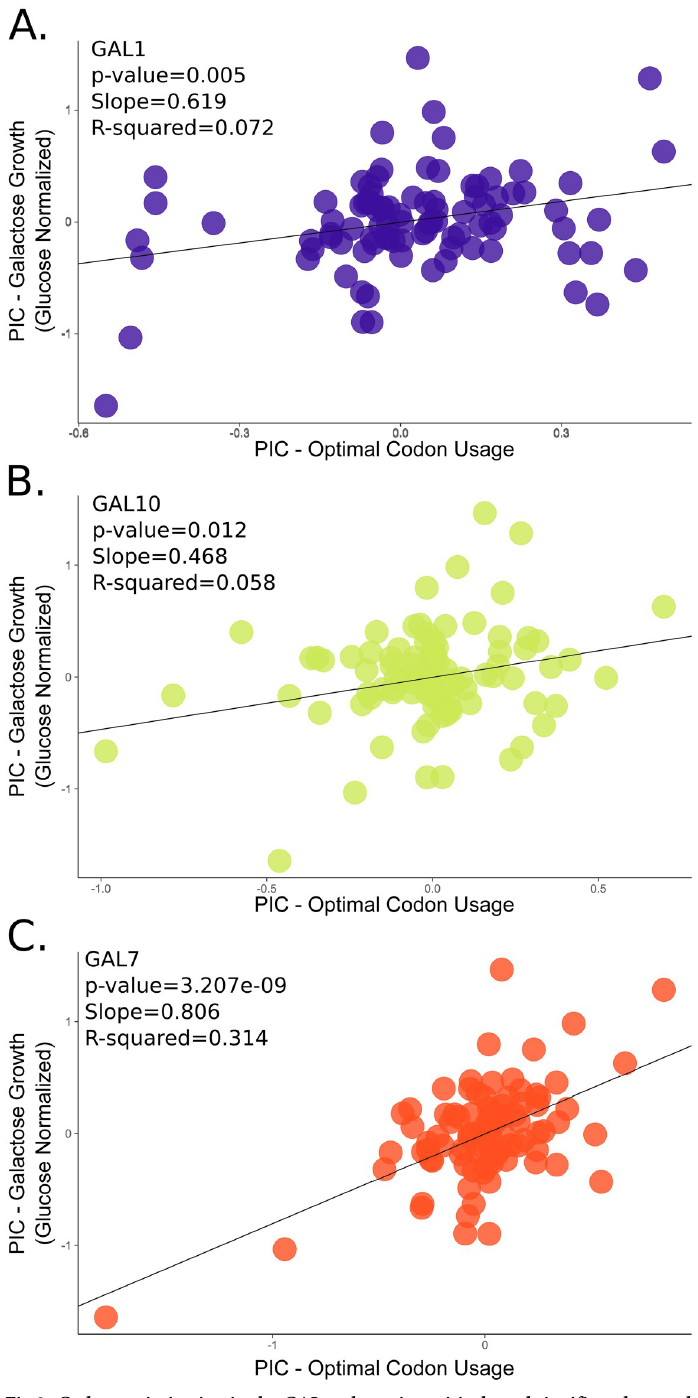
Fig 2. Codon optimization in the GAL pathway is positively and significantly correlated with growth rate on galactose. Phylogenetically independent contrasts (PIC) analyses of galactose growth ( y axis) versus GAL gene optimal codon usage ( x axis) in species that grow on galactose containing medium. Each point represents an independent contrast calculated between 2 species for either optimal codon usage or growth. A plot of the uncorrected data can be found in S11 Fig. There is a significant and positive correlation between the PIC values for codon optimization and galactose growth in GAL1 (A), GAL10 (B), and GAL7 (C). The best fit and strongest correlation is between growth on galactose and optimization in GAL7 (C). The analyses included 94 species with a growth rate on galactose greater than 0, a complete GAL cluster, and evidence of genome-wide translational selection on codon usage. One